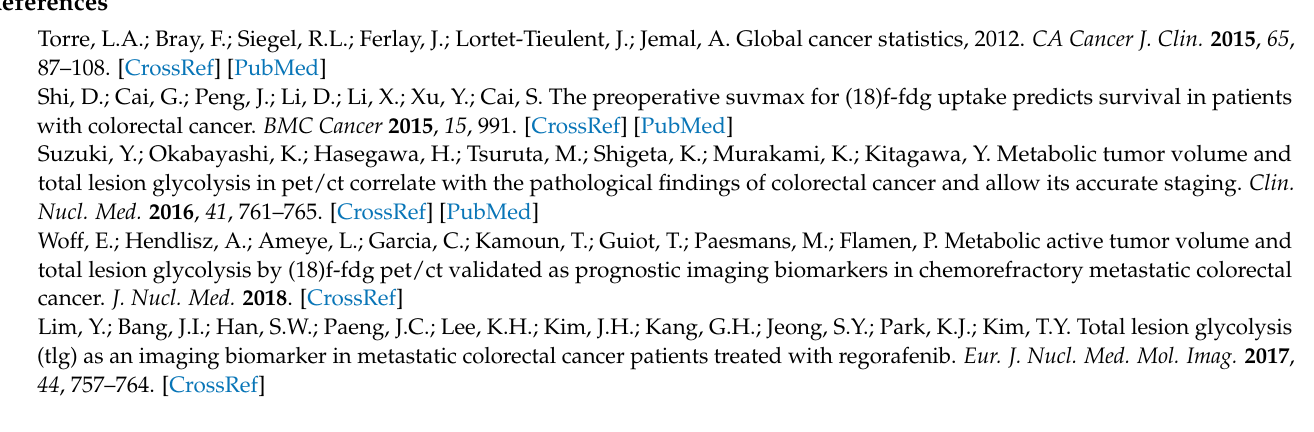
Table S5. Definition of radiomics features for Neighborhood Grey-Level Different Matrix (NGLDM), Table S6. Definition of radiomics features for Grey-Level Zone Length Matrix (GLZLM), Table S7. Intraclass correlation coefficient (ICC) results according to the each